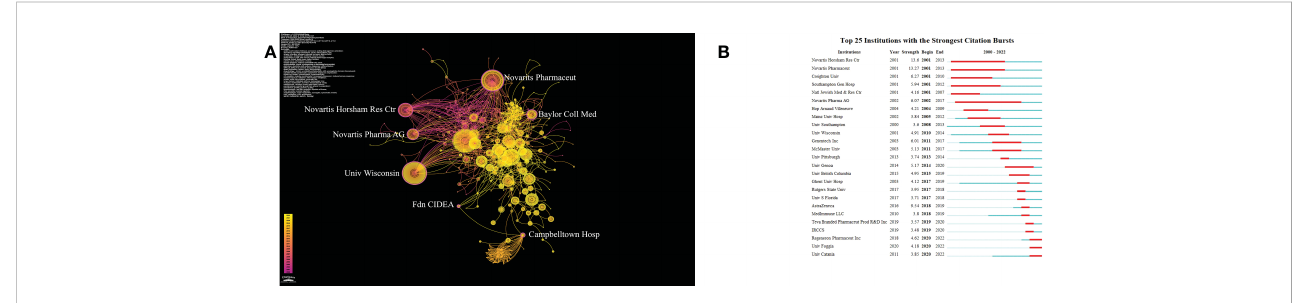
FIGURE 4 (A) The cooperation network of institutions generated by CiteSpace. In the visualization map, one node represents an institution, and its size isproportional to the number of publications. The links between nodes represent the strength of cooperation. (B) Top 25 Institutions with strongest Citation